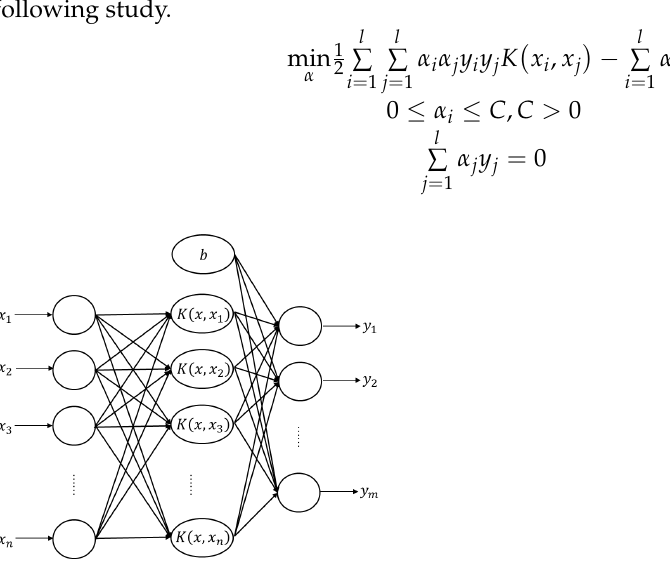
Figure 2. Nonlinear regression structure of support vector machine.